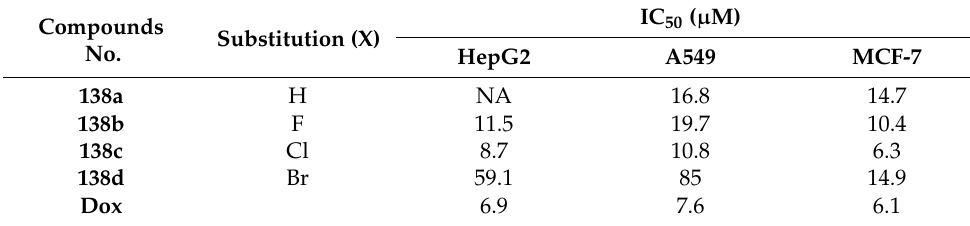
Figure 127. Structure of pyrazolo [3,4] pyridine derivatives [ 139 ( a – d ), 140 ( a – d )]. Table 114. In vitro cytotoxic activities of pyrazolo [3,4] pyridine hybrid compounds [ 139 ( a – d ), 140 ( a – d )]. Compound No.